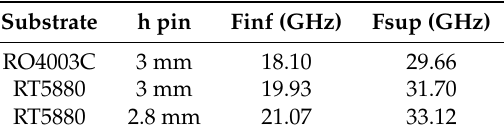
Table 1. Dispersion diagram stopband